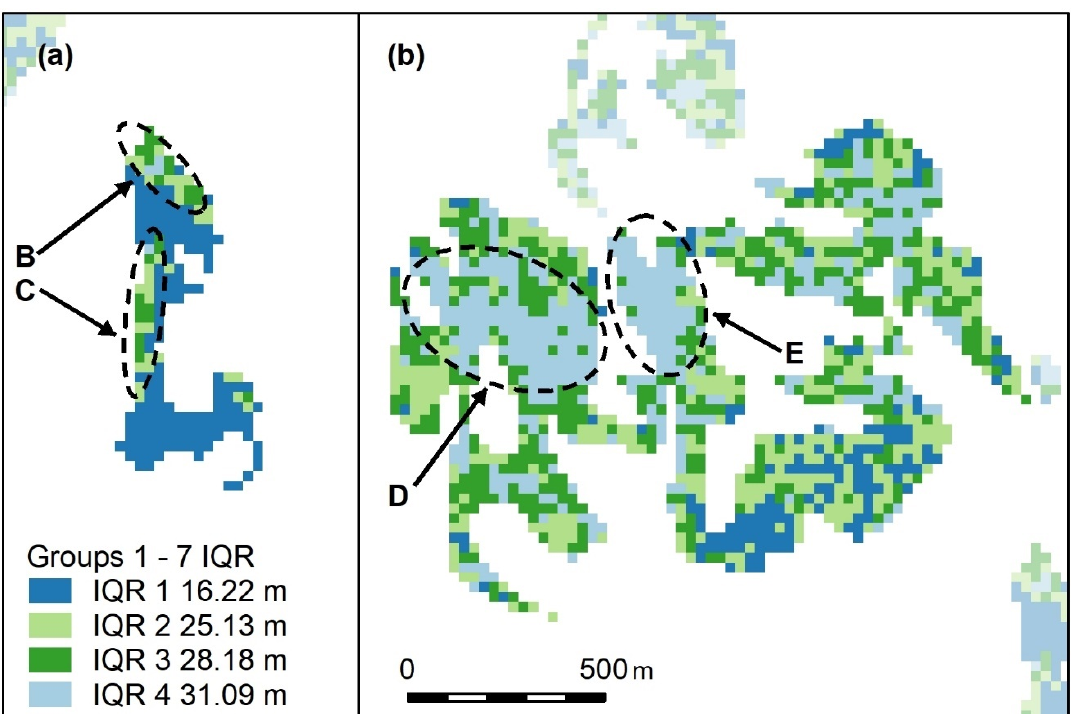
Figure A11. Selected polygon groups from Koala Coast intra-subregional Groups 6 ( a , low-canopy cohort) and 7 ( b , high- canopy cohort). Letters B–E indicate areas of higher canopy These maps are similar to Figure A1, with features B–E recognisable, but, because they encompass the entire canopy height range within the Koala Coast, B and C ( a ) are in middle IQRs (interquartile ranges), D and E ( b ) are still in the upper quartile. Lower canopy heights ( b , dark blue) adjoining B and C are pronounced. Cell colours represent the IQRs of all height data within the Koala Coast, i.e., intra-subregional Groups 1–7. IQR median heights are also shown.